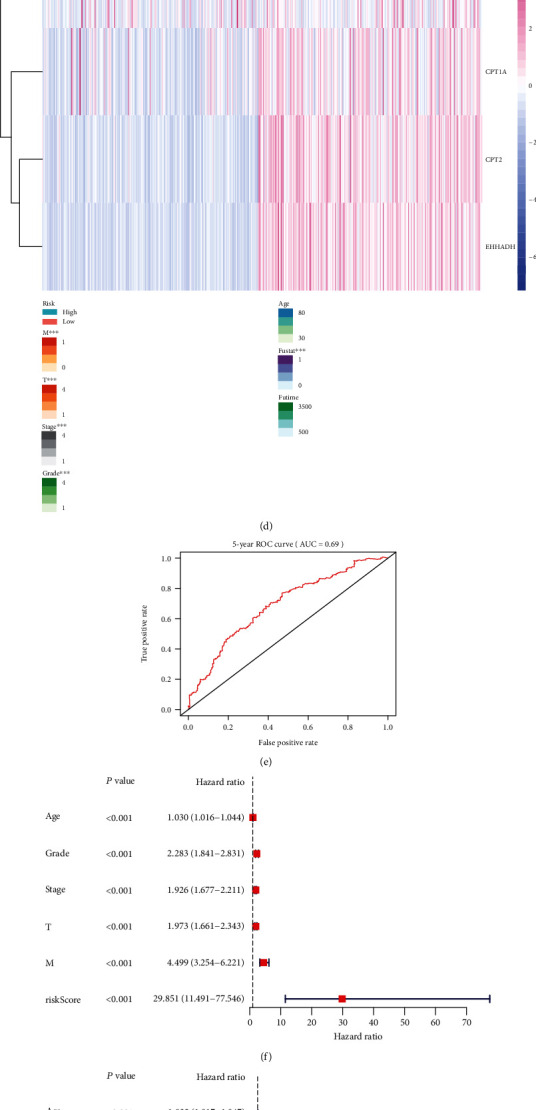
The process of establishing a risk signature. (a, b) Four genes were selected by LASSO Cox regression analysis. (c) The survival curve obtained based on this model. Red corresponds to the high-risk group, and blue corresponds to the low-risk group. (d) Based on the risk signature associated with prognosis, a heat map using data regarding the clinicopathological features of the patient was drawn. The higher the intensity of the red color, the higher is the expression. The higher is the intensity of the blue color, the lower is the expression. (e) Five-year ROC curve. (f) Univariate Cox analysis. (g) Multivariate Cox analysis. ∗∗∗P < 0.001.